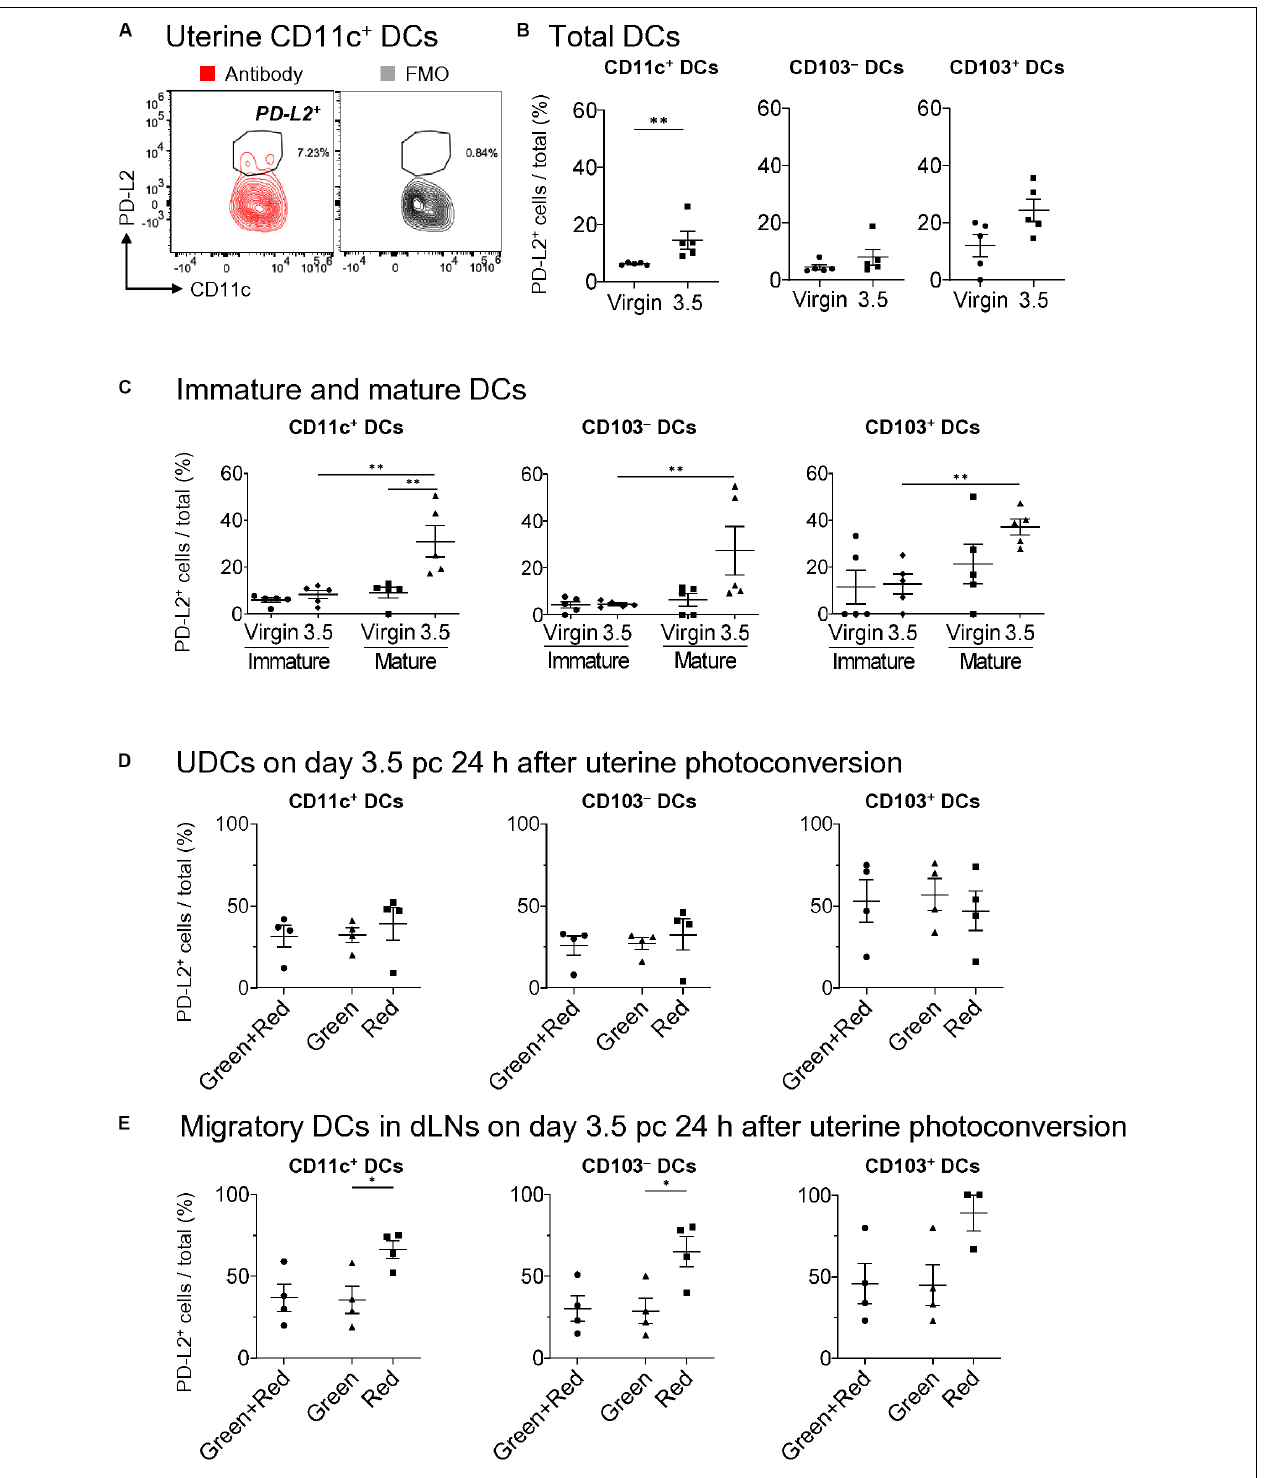
FIGURE 5 | Expression of PD-L2 in uDCs increased immediately before implantation. (A) Flow cytometry contour plots show expressions of PD-L2 in uterine CD11c + DCs with fluorescence minus one (FMO). (B,C) Proportion of PD-L2 + DCs of total DCs (B) , immature DCs, and mature DCs (C) in allogeneic mating at each time point. (D,E) Proportion of PD-L2 + DCs within the uterus (D) and dLNs (E) in allogeneic mating 24 h after uterine photoconversion on day 3.5 pc. A minimum of five (B,C) and four (D,E) samples from each time point were analyzed. Data represent mean ± SEM (B,C) and are representative of three independent experiments. Statistical comparisons were performed using Mann-Whitney U -test (B,C) and Kruskal-Wallis test with Dunn’s multiple comparisons test (D,E) ( ∗∗ P < 0.01, ∗ P < 0.05).